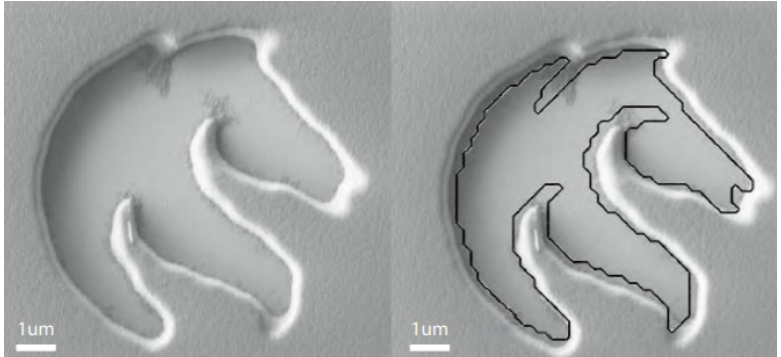
Figure 14. Electron microscope image of a seahorse feature printed using an optimized SLA technique. The right-side image has the predicted shape superimposed. The scale bar here equates to 1 µ m [107]. (Reprinted from IFAC-PapersOnLine, Volume 50, Issue 1, A. Fleming, et al., ‘Experimental Scanning Laser Lithography with Exposure Optimization’, Pages 8662-8667, Copyright (2017), with permission from IFAC).